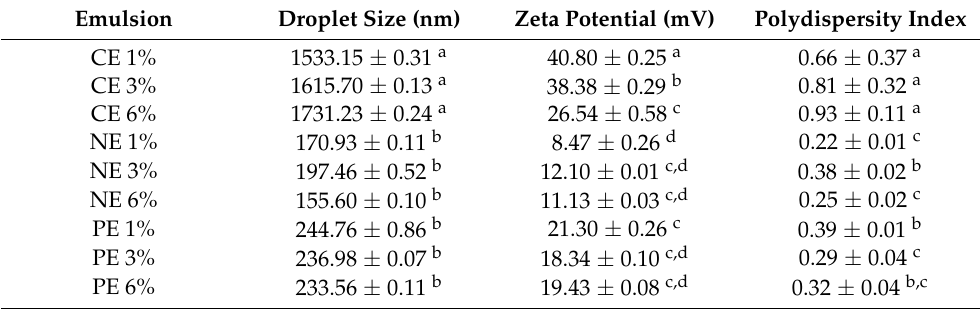
Table 1. The droplet size, zeta potential, and polydispersity index of MFEO emulsion prepared with different concentration and emulsion type.